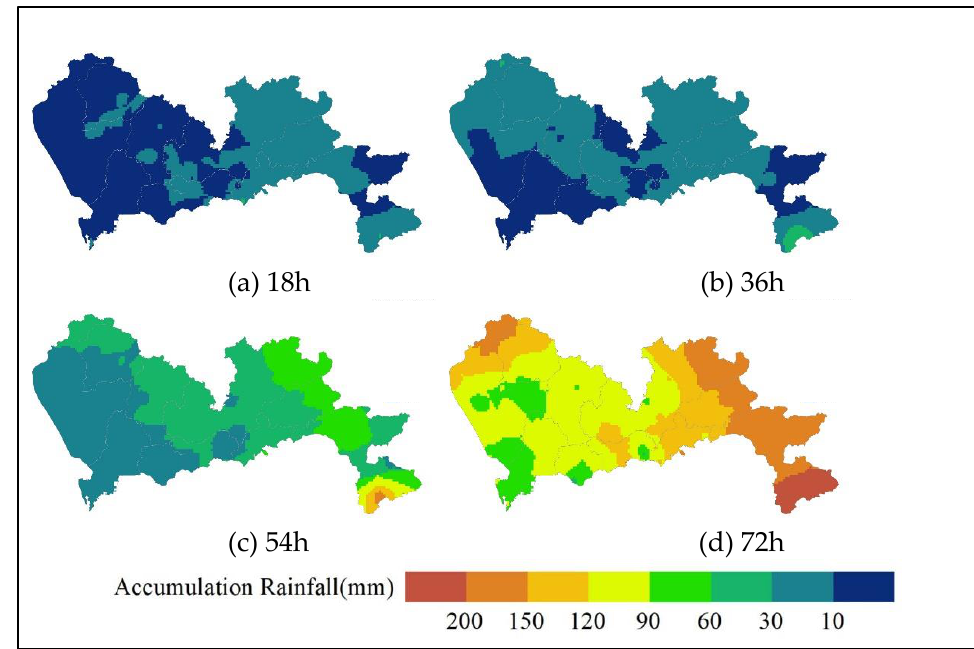
Figure 8. Temporal and spatial distribution pattern of the type II characteristics of 72 h rainfall in Shenzhen.